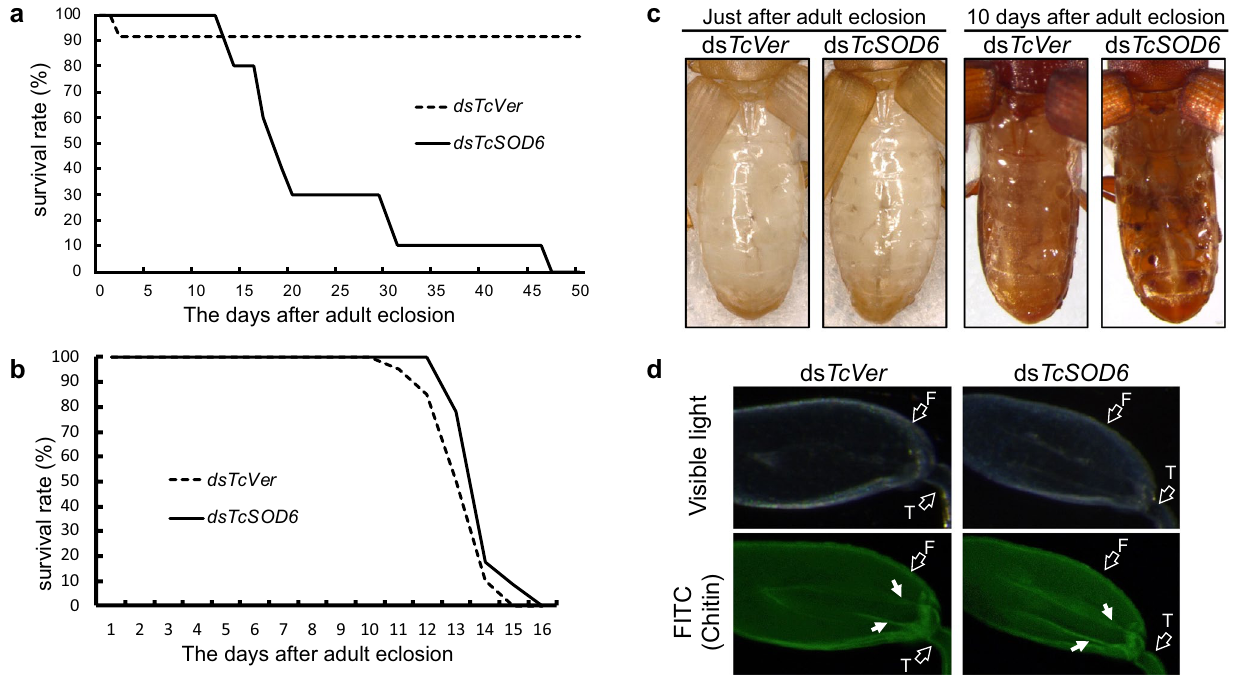
Figure 5. Phenotype of TcSOD6 -knockdown beetles. ( a ) Effect of TcSOD6 -knockdown on the adult lifespan of T. castaneum . Prepupae were treated with TcSOD6 or TcVer dsRNA. The number of live beetles was counted from adult day 0 for a period of 16 or 50 days. ( b ) without feeding. The solid line indicates TcSOD6 -knockdown adults, and the dashed line indicates TcVer -knockdown adults. ( c ) The phenotype of the abdomen in the TcSOD6 - or TcVer -knockdown group immediately after eclosion (left two panels) and at 10 days after adult eclosion (right two panels). ( d ) Observation of the tendon structure of TcVer - and TcSOD6 -knockdown adult hind legs by histochemical analysis. The tendon was stained with FITC-CBD (to detect chitin) and observed under a fluorescence microscope. White arrows indicate tendons. The open arrows indicate the parts of the hind leg; F, femur; T,